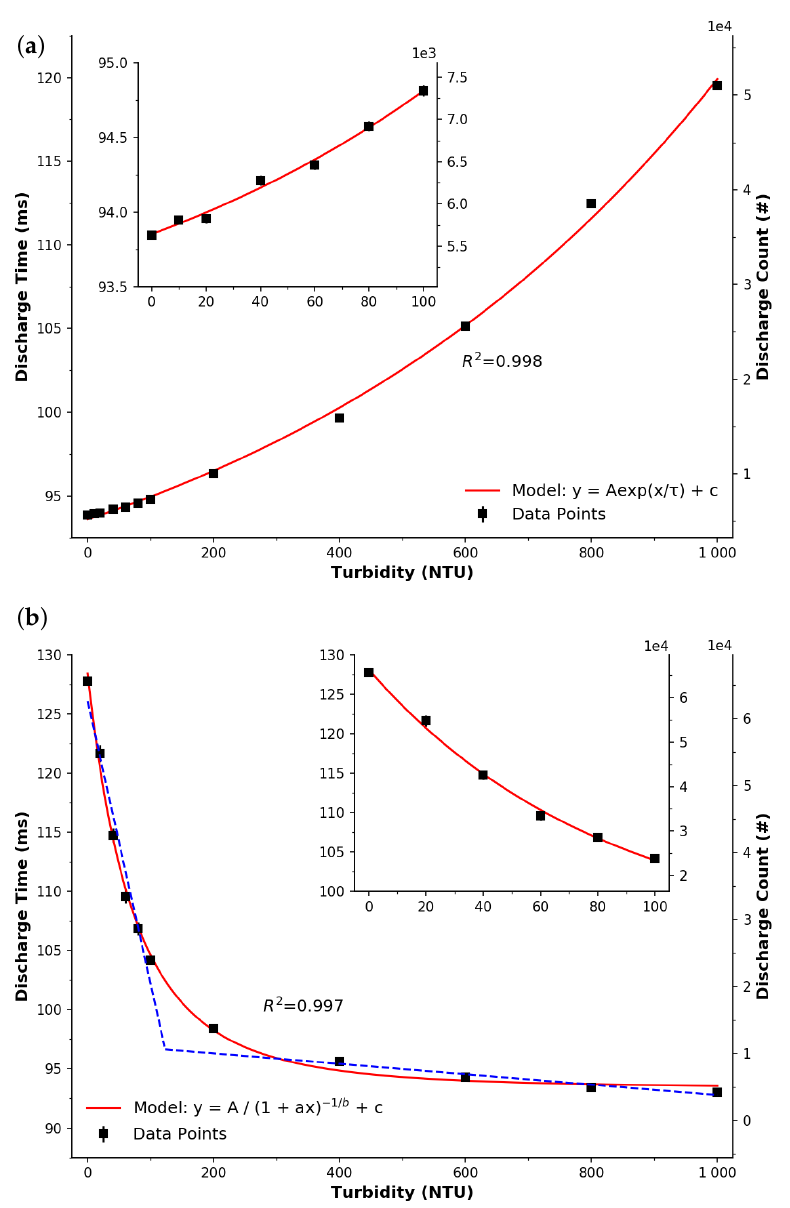
Figure 4. Response of the detector LED. The points represent the average of successive measurements and the error bars (difficult to see due to reproducibility of the data) represent the standard deviation. Insets—a magnified view of the response over a smaller range. ( a ) Detector LED facing the emit- ter LED. The red line represents a good exponential fit ( R 2 = 0.998, n = 12, y = Ae x / τ + c ). ( b ) Orthogonal arrangement. The red line represents a good power fit ( R 2 = 0.997, n = 11, y = A / ( 1 + ax ) − 1/ b + c ). The blue dashed lines represent a dual linear fitted model ( R 2 =